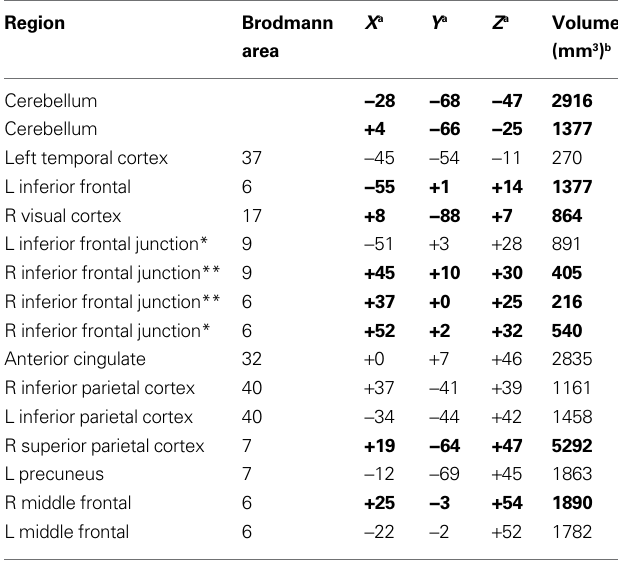
Table 4 | Regions showing group differences and training effects in cue and probe-related